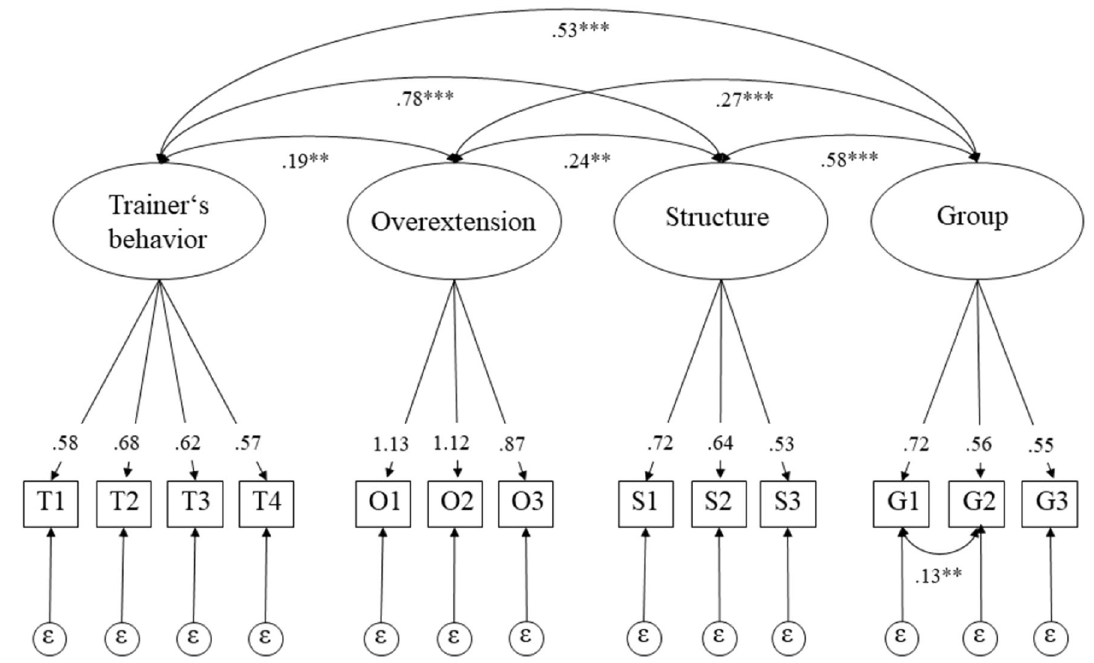
Fig. 1 Results of confirmatory factor analysis for process scales; standardized coefficients are reported. * p \ 0.05; ** p \ 0.01; *** p \ 0.001 Fig. 2 Results of confirmatory factor analysis for outcome scales; standardized coefficients are reported. * p \